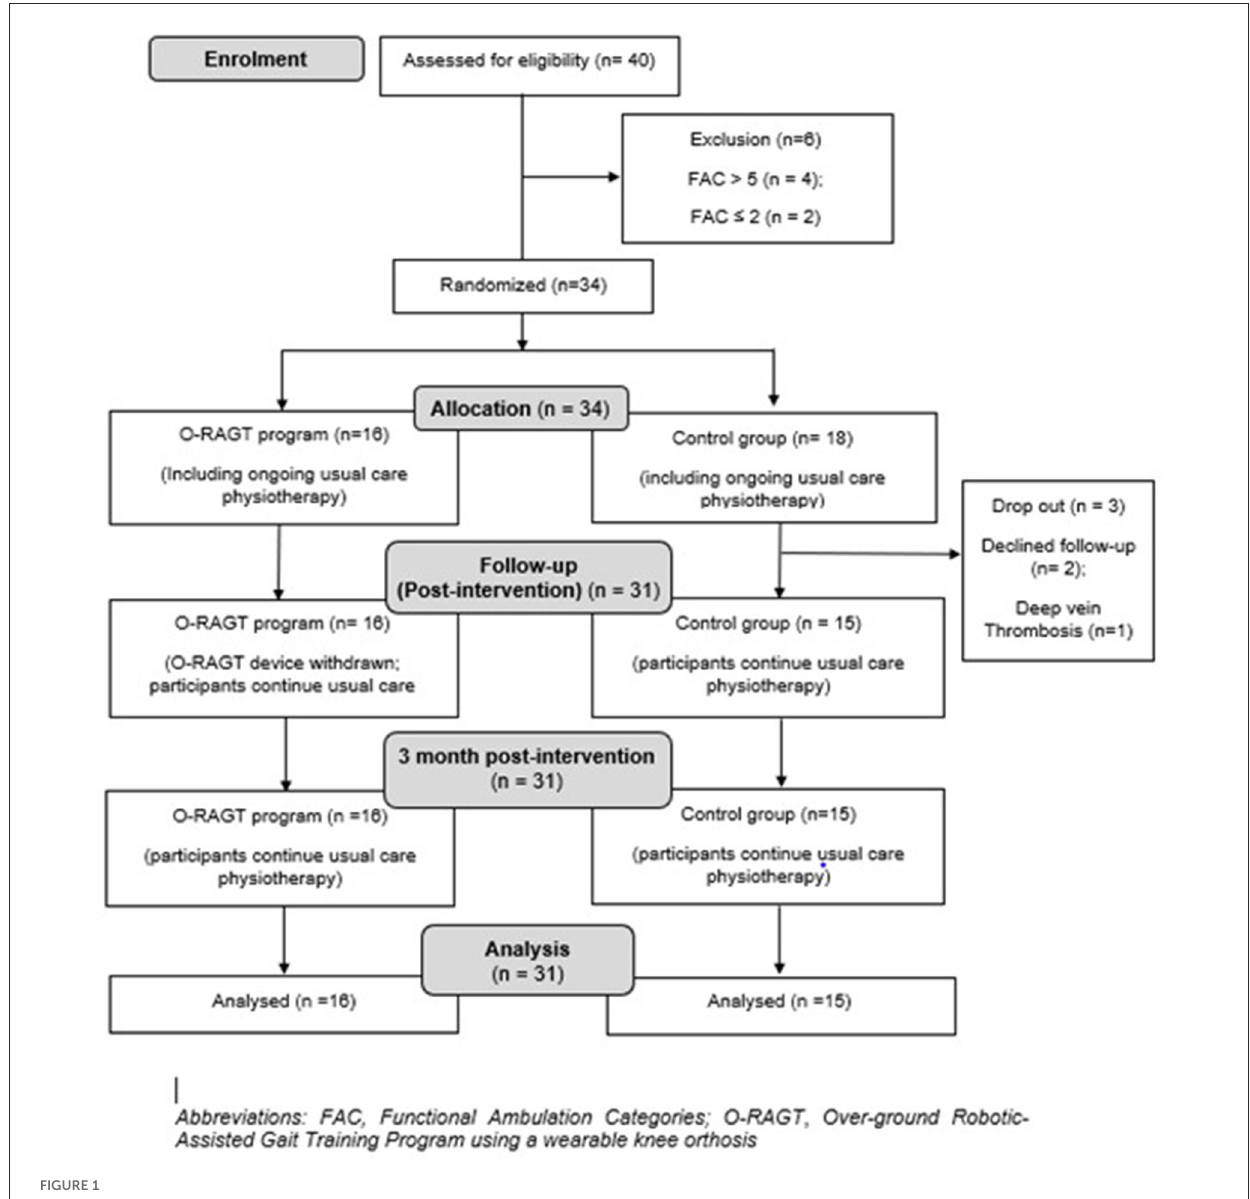
FIGURE1 Consort